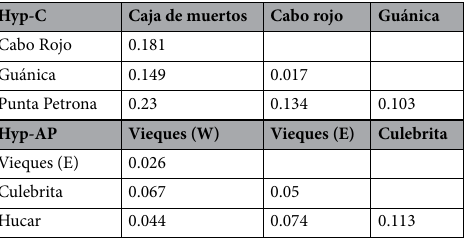
Table 2. Pairwise F ST values estimated between collection sites of both Hypogeococcus species (Hyp-C and Hyp-AP) using Wright and Cockerham method.